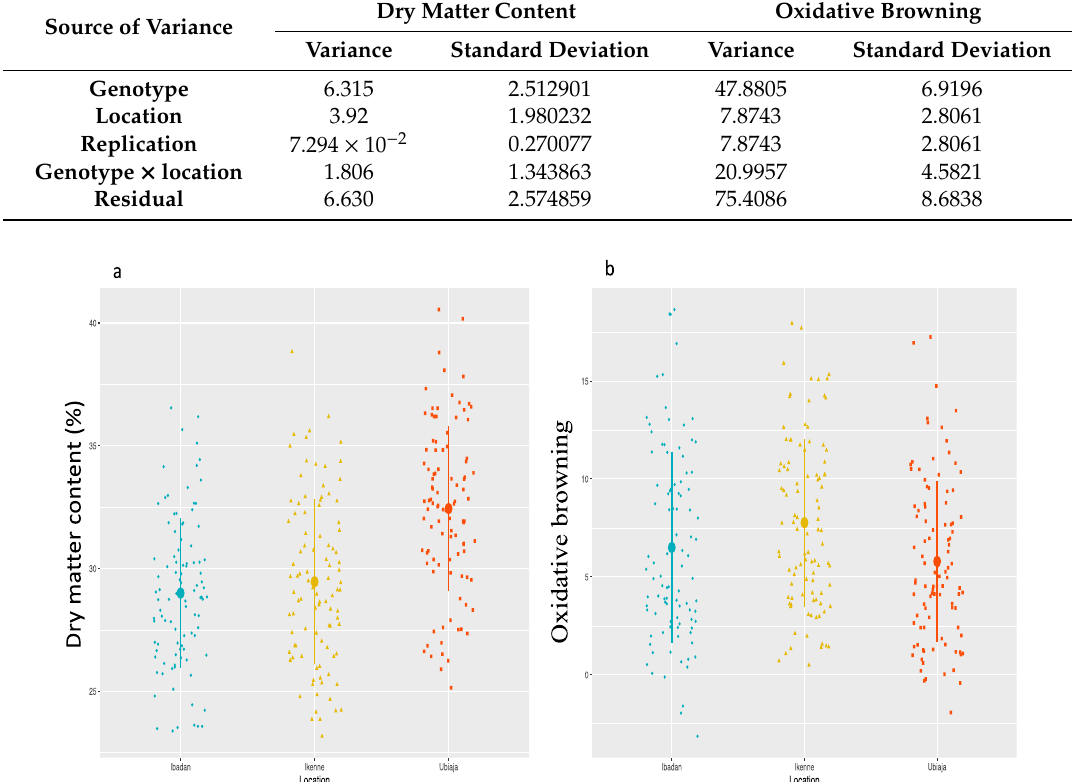
Table 1. Estimates of variance for total genotypic and genotype × location e ff ects in a panel of 100 water yam clones phenotyped at three locations.